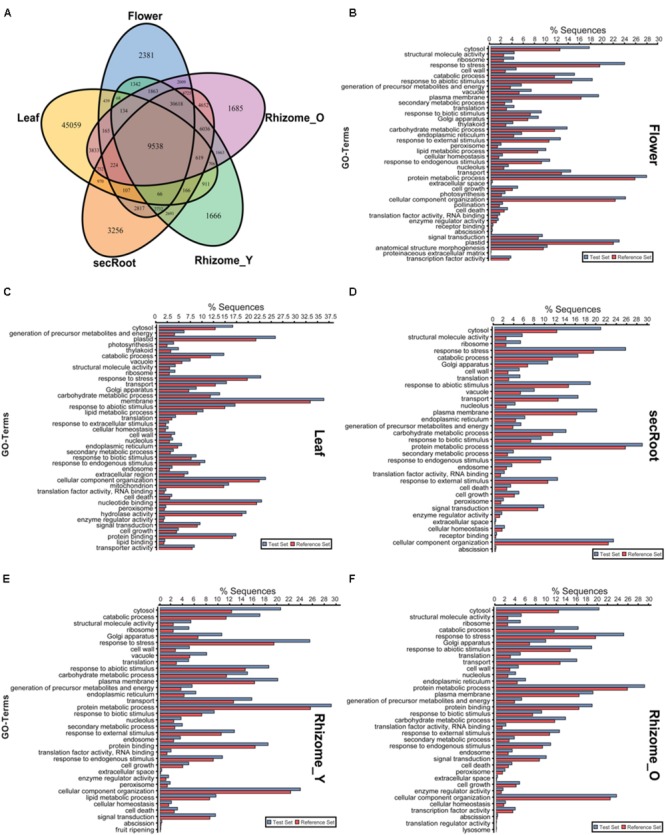
Distribution of unigenes and gene ontology enrichment analysis for five tissues of P. japonicus. (A) Venn diagram for unigenes with non-zero FPKM values in individual tissues. (B–F) Gene ontology enrichment analysis using Fisher’s exact test with P-value cutoff applied as 0.05. Unigenes for each tissue with FPKM value above 10 were selected as test set, and used against the P. japonicus transcriptome assembly as reference set to identify differential GO-terms enriched in the specific tissue, with P-value being calculated based on reference set.